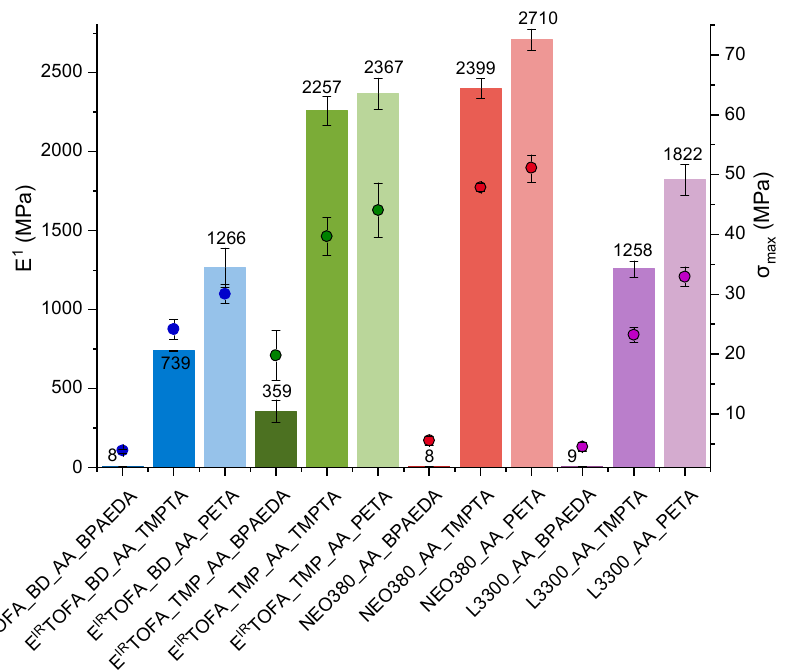
Figure 7. Tensile modulus (Young’s) (E 1 ) and tensile strength ( σ max ) for the polymers from tall oil polyol or commercial polyol ‐ based acetoacetates and BPAEDA, TMPTA, and PETA acrylates.